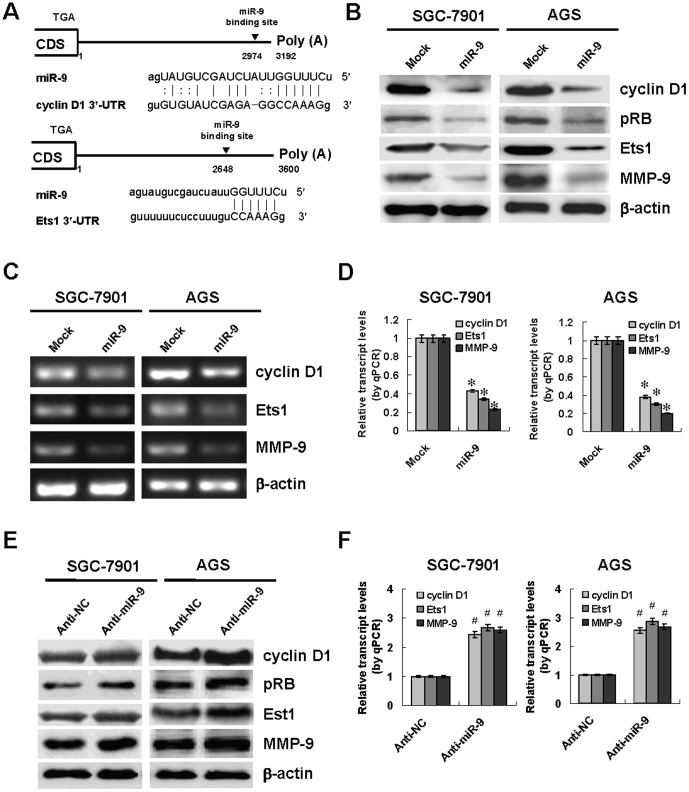
miR-9 suppressed the expression of cyclin D1 and Ets1 through post- transcriptional repression in gastric cancer cells.
A, scheme of the potential binding sites of miR-9 in the 3′-UTR of cyclin D1 and Ets1, locating at bases 2974–2995 and 2648–2670, respectively. B, stable transfection of miR-9 precursor resulted in decreased protein levels of cyclin D1, Ets1 and their downstream targets pRB and MMP-9 in gastric cancer SGC-7901 and AGS cells than those transfected with negative control vector (mock). C and D, the transcript levels of cyclin D1, Ets1 and MMP-9 were decreased in miR-9 precursor-transfected SGC-7901 and AGS cells, when compared to those in mock cells. E, transfection of anti-miR-9 inhibitor (100 nmol/L) resulted in increased protein levels of cyclin D1, Ets1 and their downstream targets pRB and MMP-9 in SGC-7901 and AGS cells than those transfected with negative control inhibitor (anti-NC, 100 nmol/L). F, the transcript levels of cyclin D1, Ets1, and MMP-9 were increased in SGC-7901 and AGS cells transfected with anti-miR-9 inhibitor (100 nmol/L), when compared to those transfected with anti-NC (100 nmol/L). The symbols (* and #) indicate a significant decrease and a significant increase from mock or anti-NC, respectively.